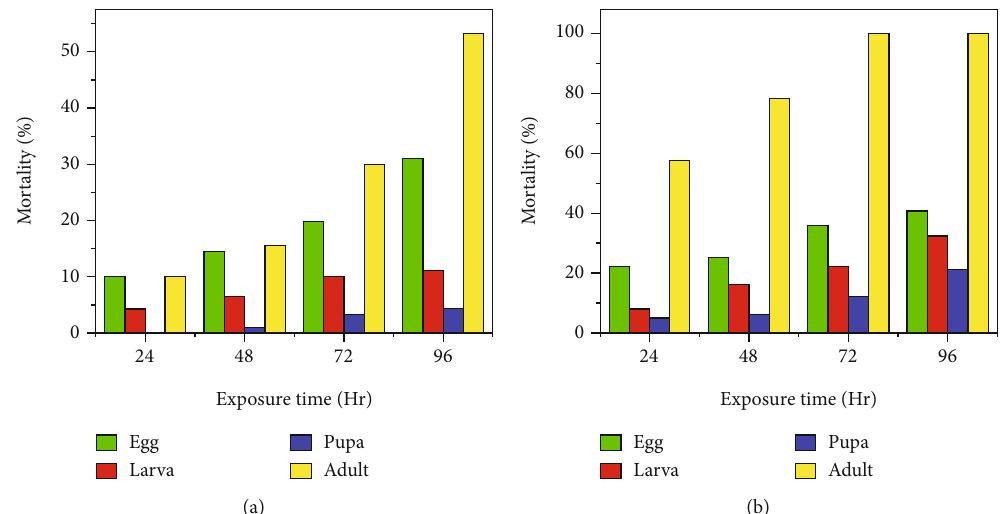
Figure 4: Mortality of Callosobruchus maculatus egg, larva, pupa, and adult at (a) 10% CO